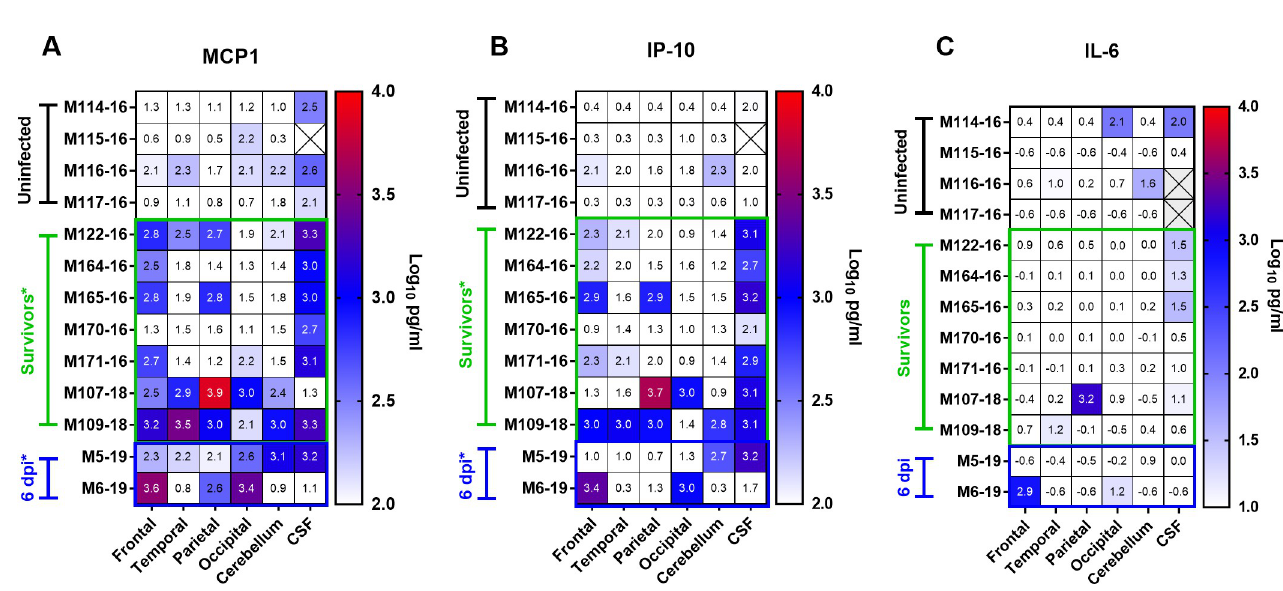
Fig 10. Cytokines in the CSF of VEEV-infected NHP at necropsy. Multiplex analysis was used to measure cytokines in the CSF of mock-infected or surviving VEEV-infected animals at necropsy. (A) MCP-1. (B) IP-10. (C) IL-6. Statistical significance determined by 2-way ANOVA with multiple comparisons. In (A) and (B), both groups of VEEV-infected animals had elevated chemokine levels compared to mock infected controls.